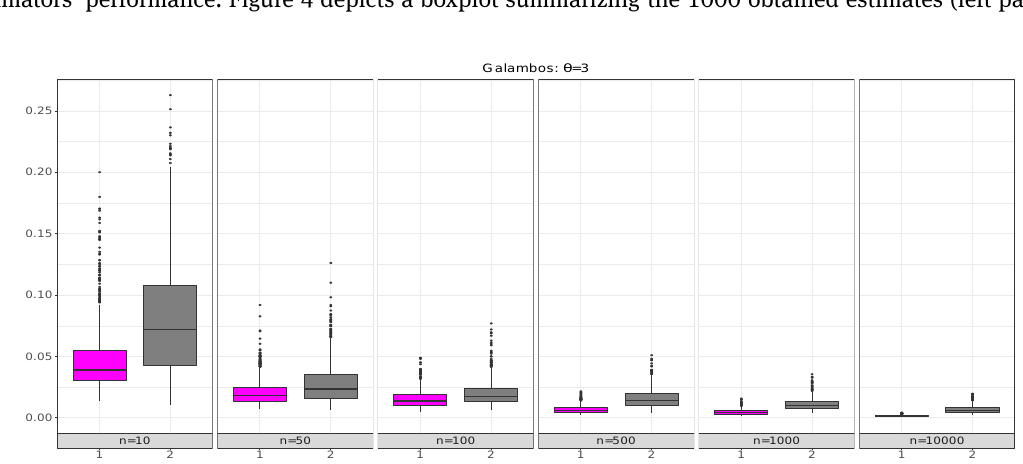
estimator based on ˆ A * , right panel: estimator based on checkerboard approximations) for CoES = n at levels α = 0.05 and γ =